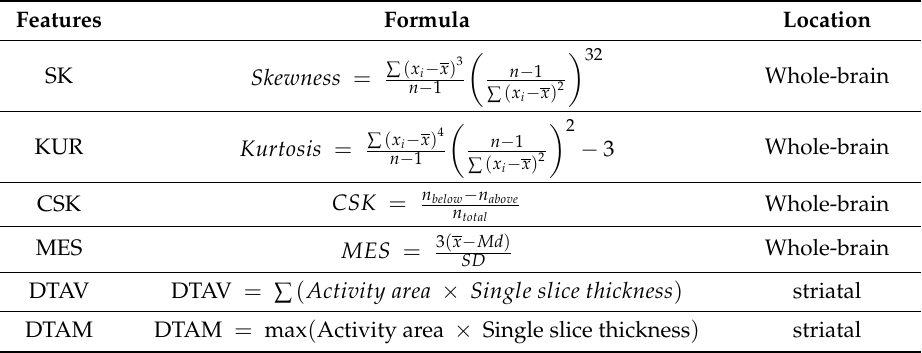
Table 1. Six features were calculated from whole brain and